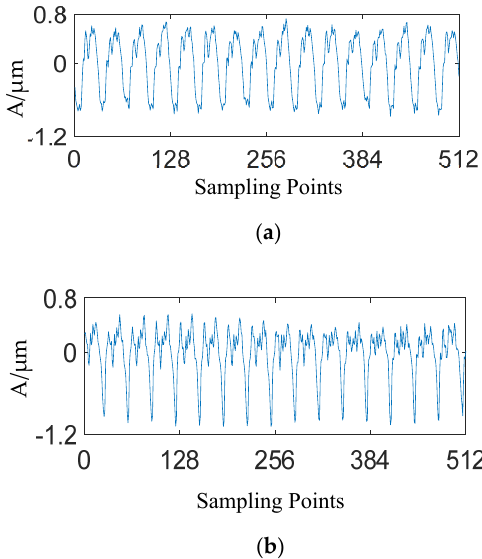
Figure 21. Vibration signal of rubbing fault. ( a ) Slight rubbing ( b ) Serious rubbing.